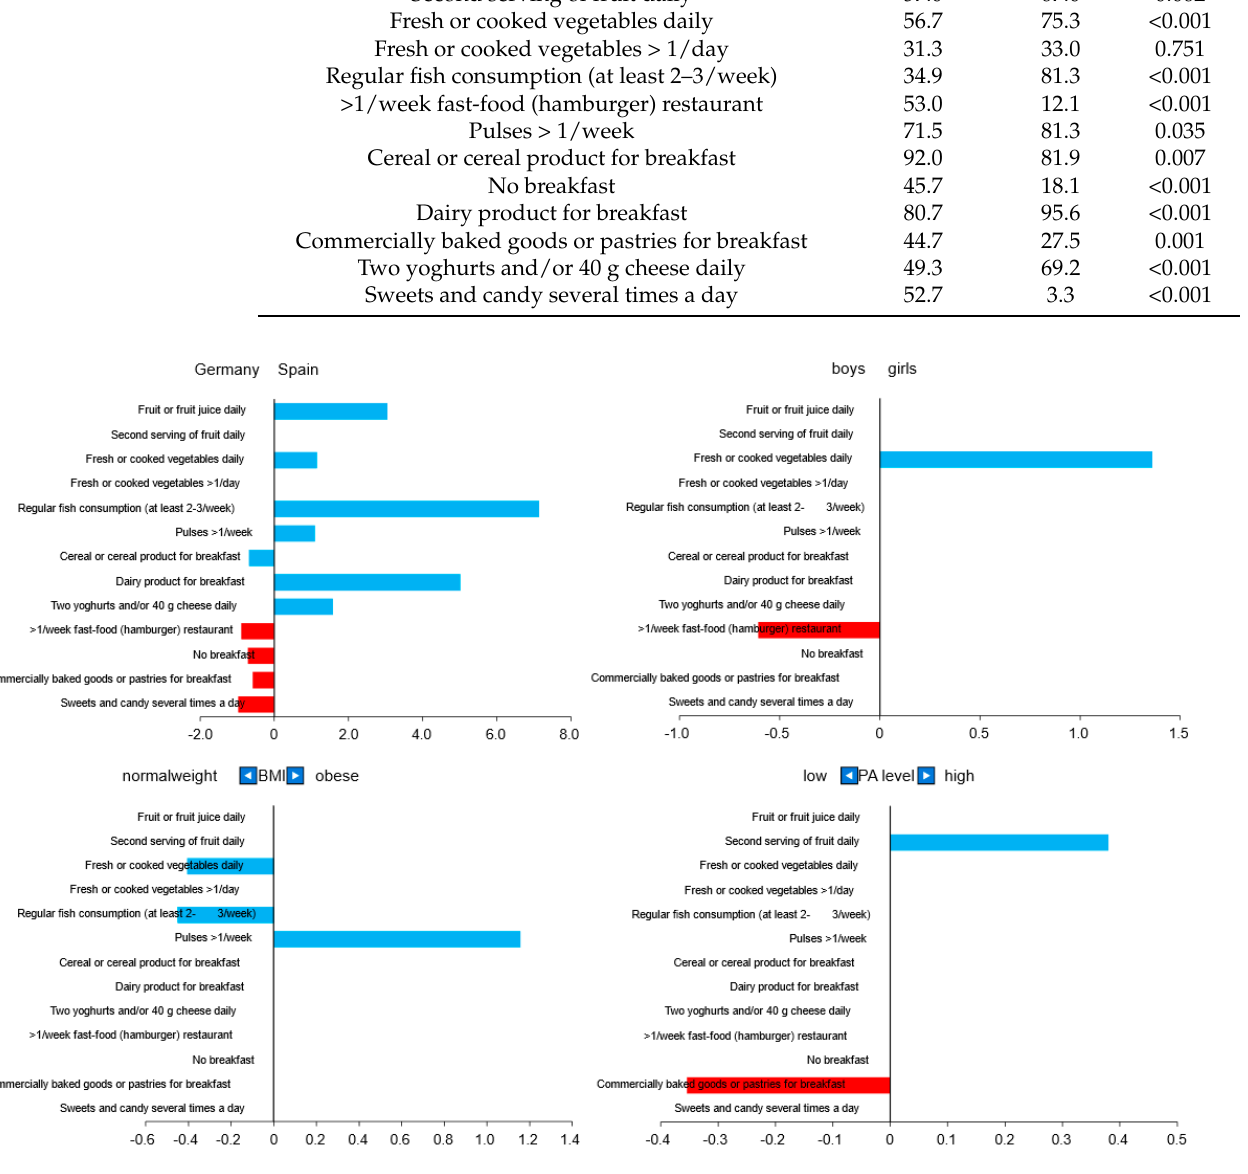
Figure 2. Odd ratios for each KIDMED question for country, gender, BMI group, and PA level. Blue: Questions with a positive aspect (+1); red: Questions with a negative aspect ( − 1). PA: Physical